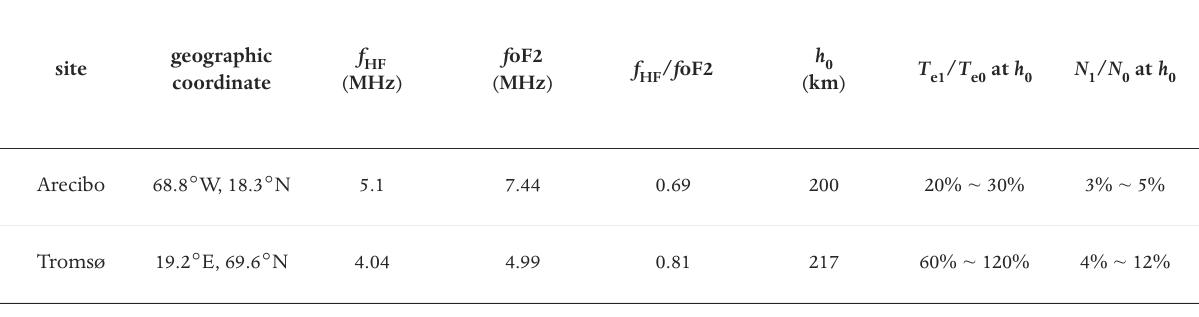
refers to the 0